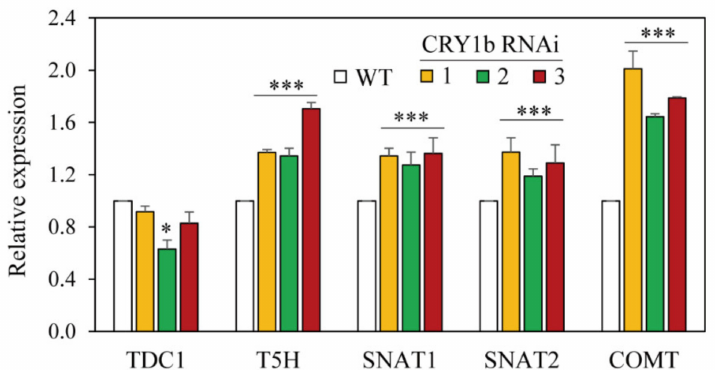
Figure 4. Quantitative real-time PCR analyses of melatonin biosynthesis genes. TDC1 , tryptophan decarboxylase 1; T5H , tryptamine 5-hydroxylase; SNAT1 , serotonin N -acetyltransferase 1; SNAT2 , serotonin N -acetyltransferase 2; COMT , caffeic acid O -methyltransferase. * p < 0.05 and *** p <